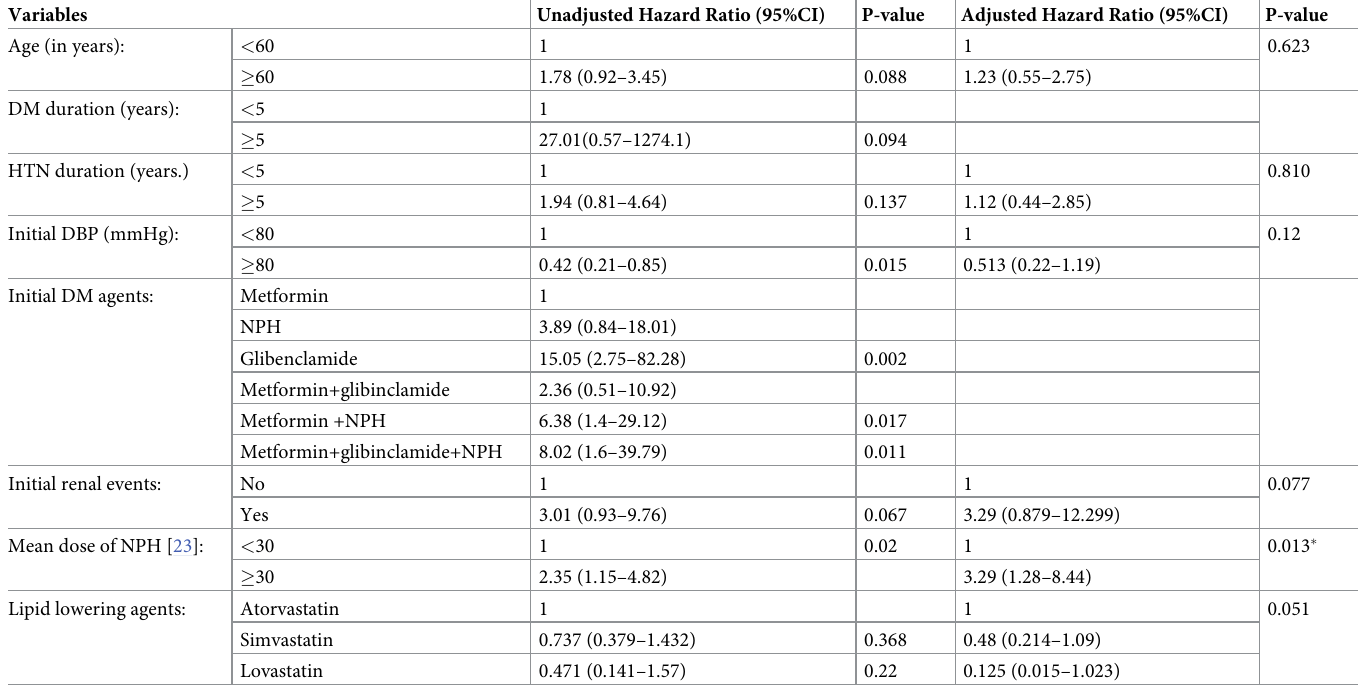
Table 3. Predictors and hazard ratios (95% CI) for doubling of serum creatinine in the five-year follow-up in patients with